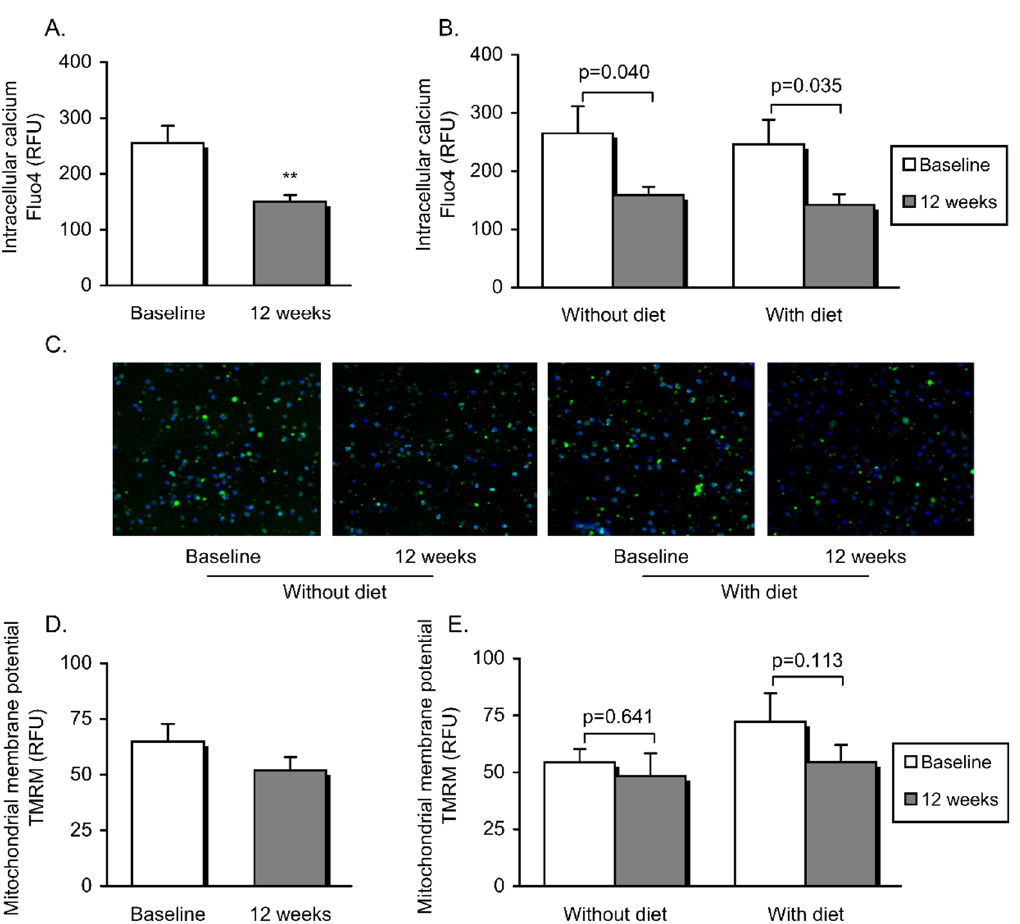
Figure 2. Mitochondrial function and cytosolic Ca 2 + in patients’ leukocytes prior to and following non-surgical periodontal treatment and dietary weight loss intervention. Intracellular calcium was calculated as arbitrary units of Fluo4 fluorescence ( A , B ). Fluorescence microscopy images of leukocytes labelled with Fluo4 (green) and Hoechst 33,342 (blue) for nuclei staining ( C ). Mitochondrial membrane potential was measured as the mean of fluorescence intensity of TMRM ( D , E ). Data are shown as mean + standard error. A paired Student’s t -test (** p < 0.01) was used to compare the whole obese population before and after the intervention. Obese patients undergoing vs. those not undergoing dietary therapy were compared before and after intervention (also using a paired Student’s t -test; differences were considered significant when p < 0.05).